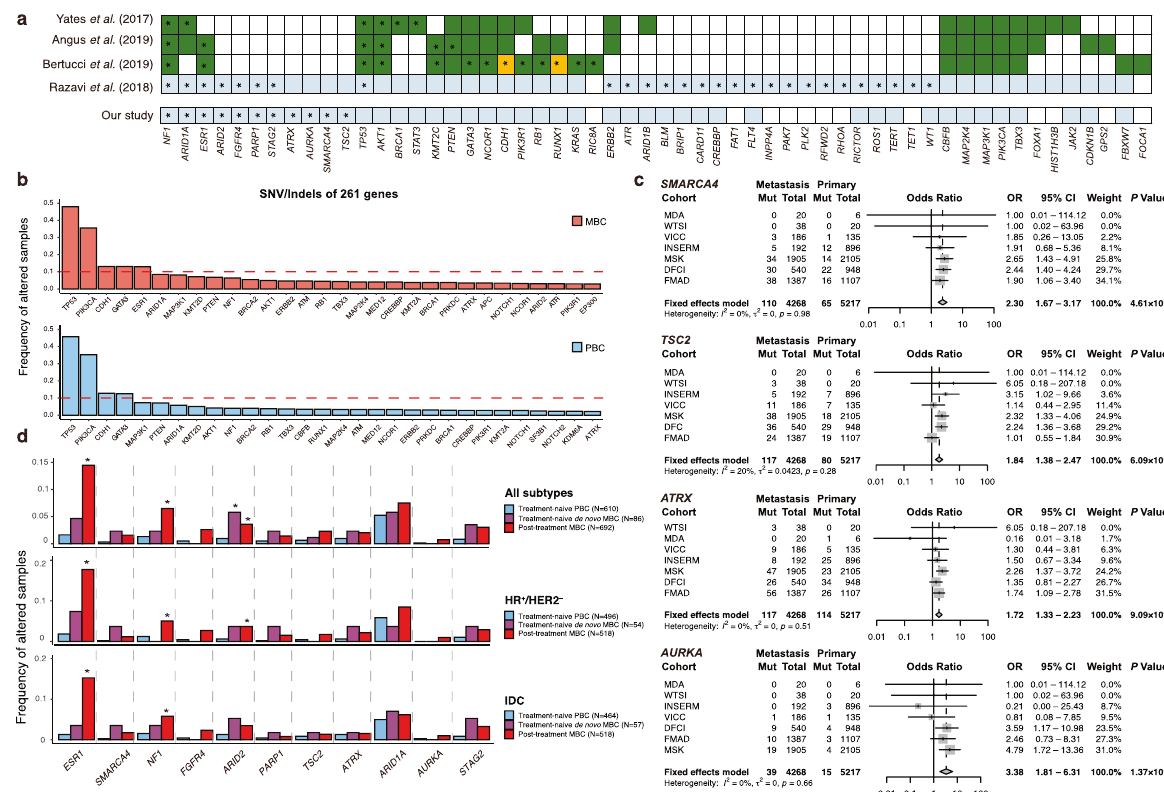
Fig. 2 Frequently altered genes in pan-metastatic breast cancer. a Candidate MBC driver genes and MBC-enriched altered genes compared with those in PBC are shown. Thirty-one genes identi fi ed as MBC driver genes in three previous studies are shown in dark green. These studies used MutSigCV or dNdScv for different datasets to identify MBC driver genes. To identify MBC-enriched altered genes, these studies compared the mutational frequency of the detected driver genes between unpaired MBC and PBC, whereas we and Razavi et al. 7 compared cancer- related targeted genes between unpaired MBC and PBC. The targeted genes in the study by Razavi et al. 7 and our study are shown in light blue, and the rest of the targeted genes are listed in Supplementary Table 6 and are described in Razavi et al. 7 , respectively. Asterisks indicate that the tested genes were signi fi cantly enriched in MBC for each study (signi fi cantly enriched genes in PBC are colored in orange and denoted by an asterisk). To compare the mutational frequency per gene between MBC and PBC, we used meta-analysis and logistic regression analysis, whereas the other studies used Fisher ’ s exact test. b Top 30 frequently altered genes are presented. The upper panel shows MBC samples, and the lower panel shows PBC samples. c Forest plots present four signi fi cantly altered genes ( SMARCA4 , TSC2 , ATRX , and AURKA ) that were identi fi ed by our meta-analyses and logistic regression analyses and were not shown as MBC-enriched genes in previous studies 7,10,14,15 . Results of fi xed-effects meta-analyses and heterogeneity tests between cohorts are shown. P values were adjusted by the false discovery rate (FDR). d Frequency of samples with mutations of the identi fi ed 11 genes according to treatment history and subtypes. Statistically signi fi cant difference of the mutational frequency in PBC with de novo MBC or post-treatment MBC are indicated by an asterisk (FDR < 0.05 from logistic regression site-speci fi c analysis at a gene level (Fig. 3) (OR = 4.24 vs. 0.19; 95% CI = 2.91 – 6.23 vs. 0.07 – 0.42; FDR = 1.96 × 10 − 12 vs. 7.71 ×